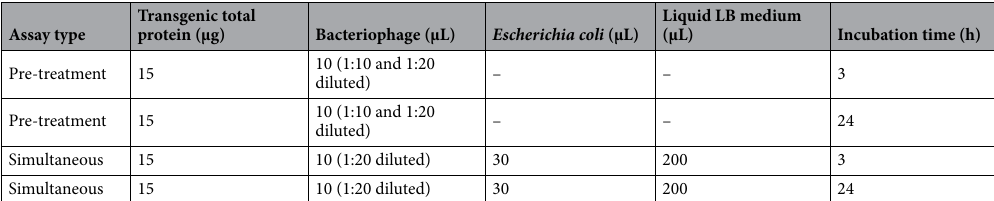
Table 2. Anti-bacteriophage activity of MAP30. The pre-treatment and simultaneous assays was conducted in two periods of the time using transgenic total protein and bacteriophage in different dilutions (1:10 and 1:20).